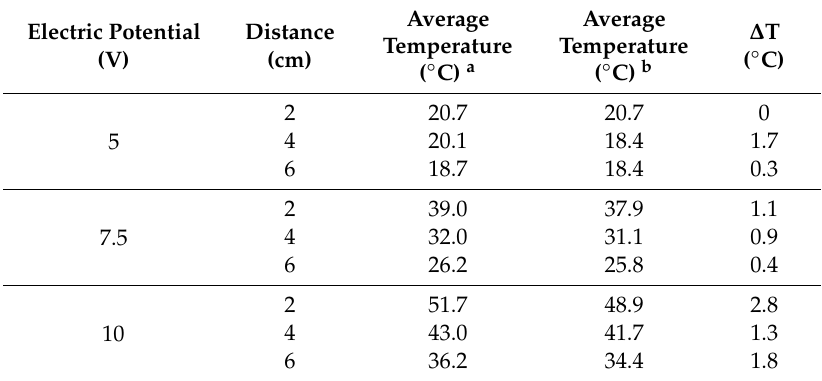
Figure 9. Thermal variation ( ∆ T) of the average temperature obtained in random fibers of EM3 and EM4 varying the irradiation distance and electric potential. Table 6. Thermal variation ( ∆ T) between the infrared thermography values recorded for EM4 with random and aligned fibers